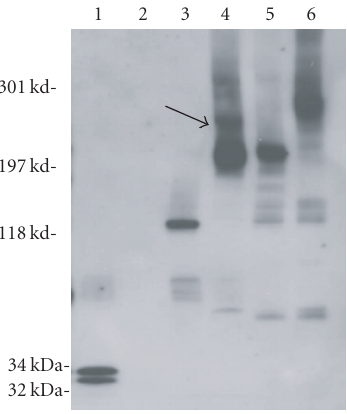
Figure 3: Oligomers formed by PVL and modified toxins. Oligomers were checked in solution or after recovery from treated human PMNs, 3–8% (w/v) SDS-PAGE and immunoblotting with anti-LukS-PV and anti-LukF-PV a ffi nity-purified rabbit antibodies. Lane 1: LukS-PV + LukF-PV without membranes, lane 2: PMNs only, lane 3: GST ∼ LukS-PV + GST ∼ LukF-PV, lanes 4, 5, 6: tox- ins applied on PMNs membranes and then saponin/glutaraldehyde treated and heated 5 minutes at 100 ◦ C as described in materials and methods, lane 4: LukS-PV + GST ∼ LukF-PV, lane 5: GST ∼ LukS-PV + LukF-PV, lane 6: GST ∼ LukS-PV + GST ∼ LukF-PV.